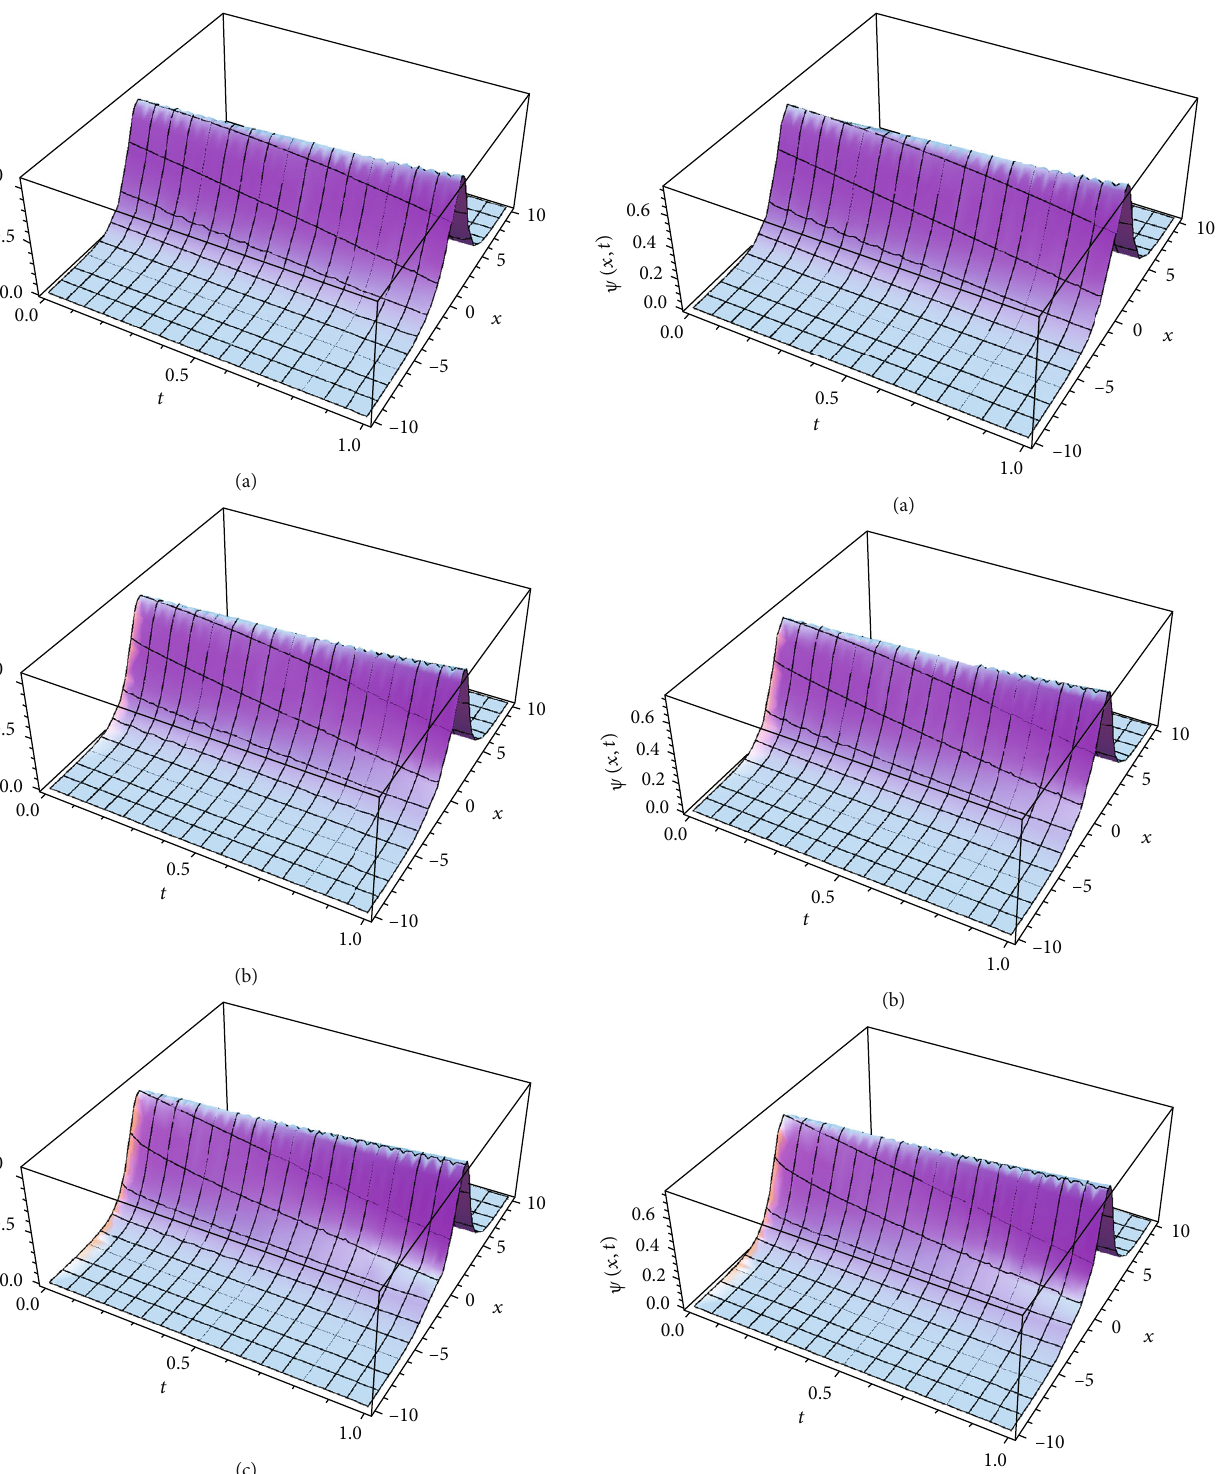
Figure 1: The NDM solutions ϕ ð x , t Þ for Example 1 when a = 1 , b = 3 , ζ = 1 , and r = 1 : (a) α = 1, β = 1 ; (b) α = 0 : 75, β = 0 : 75 ; (c) α = 0 : 5, β = 0 : 5 .